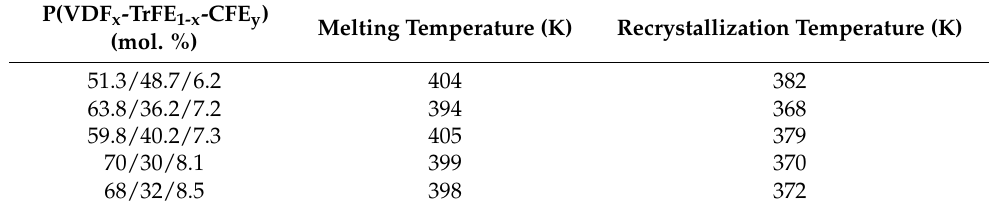
Table 2. The melting and recrystallization temperatures of the studied compositions estimated from DSC